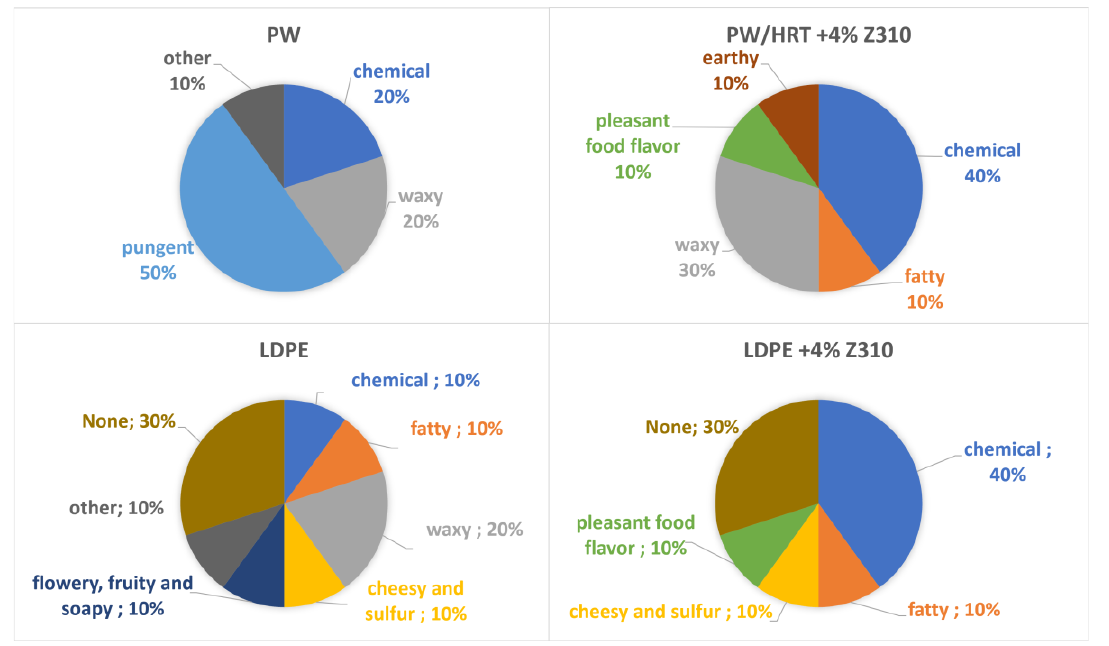
Figure 14. Description of odors perceived by the panelists about the samples: PW, PW/HRT+4% Z310, LDPE, LDPE+4% Z310.